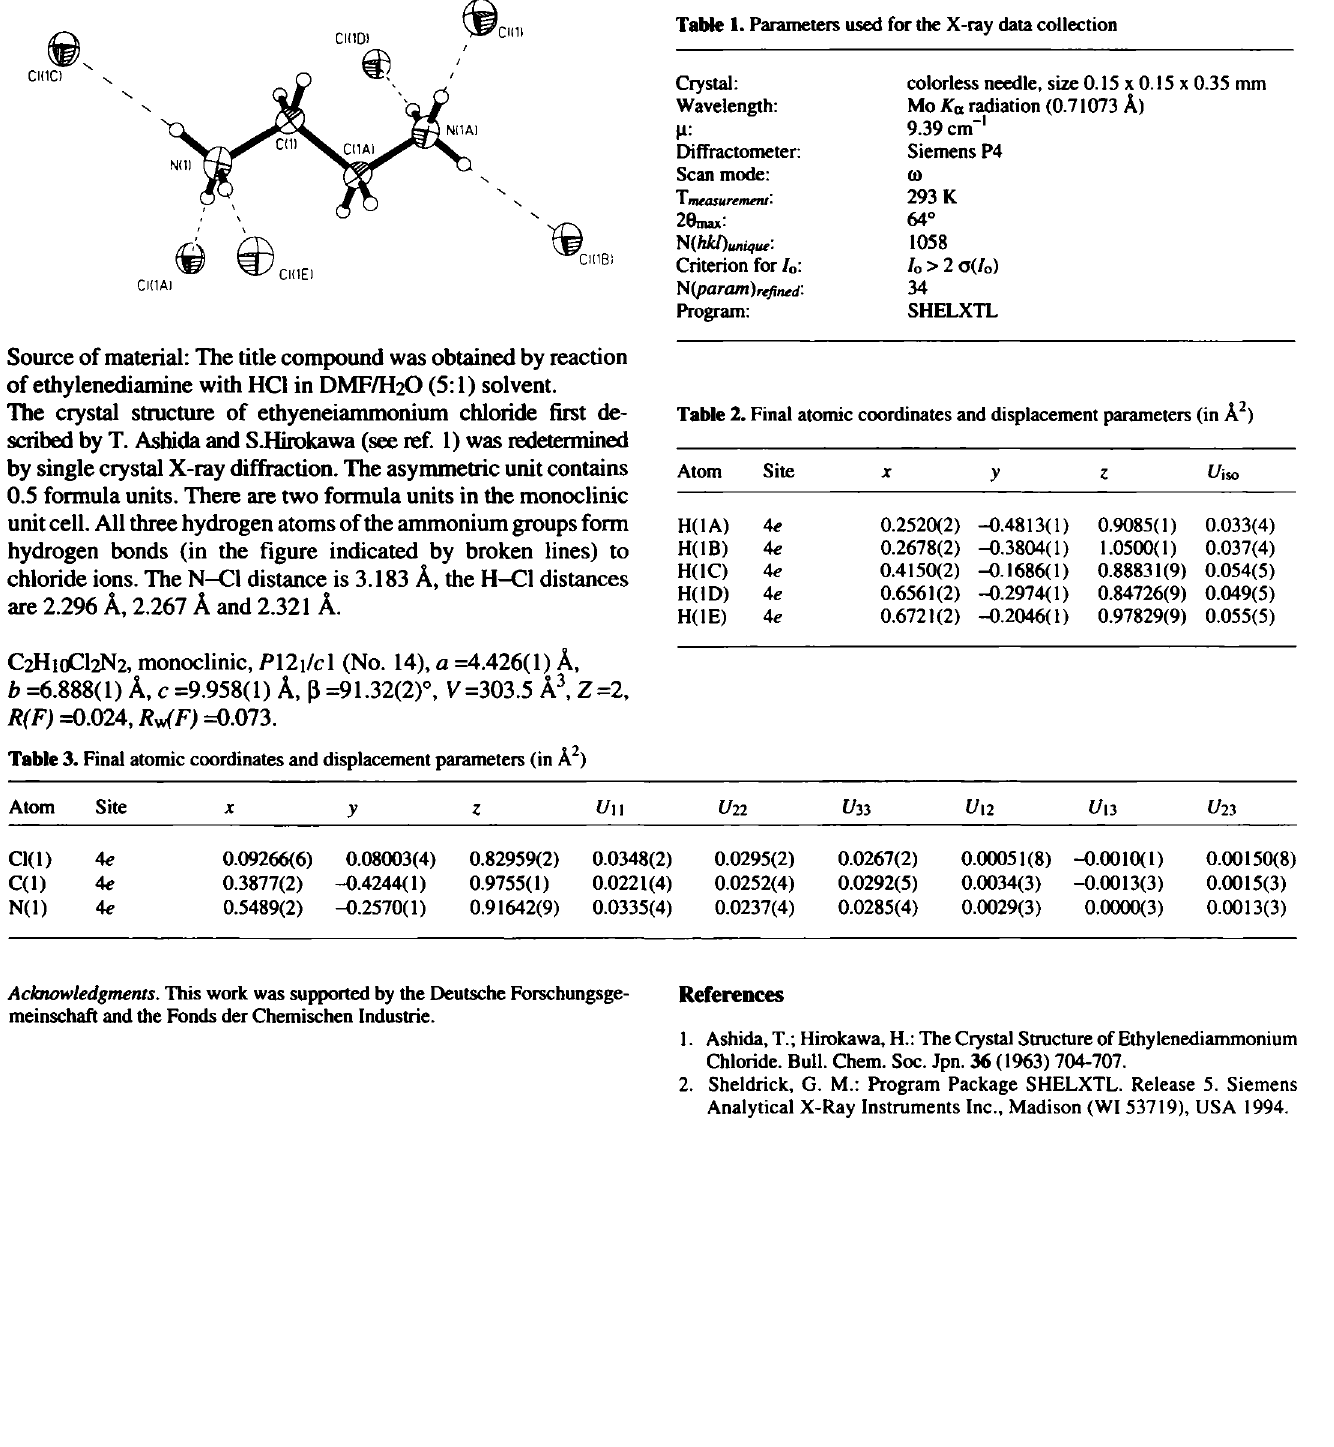
Table 2. Final atomic coordinates and displacement parameters (in Â 2